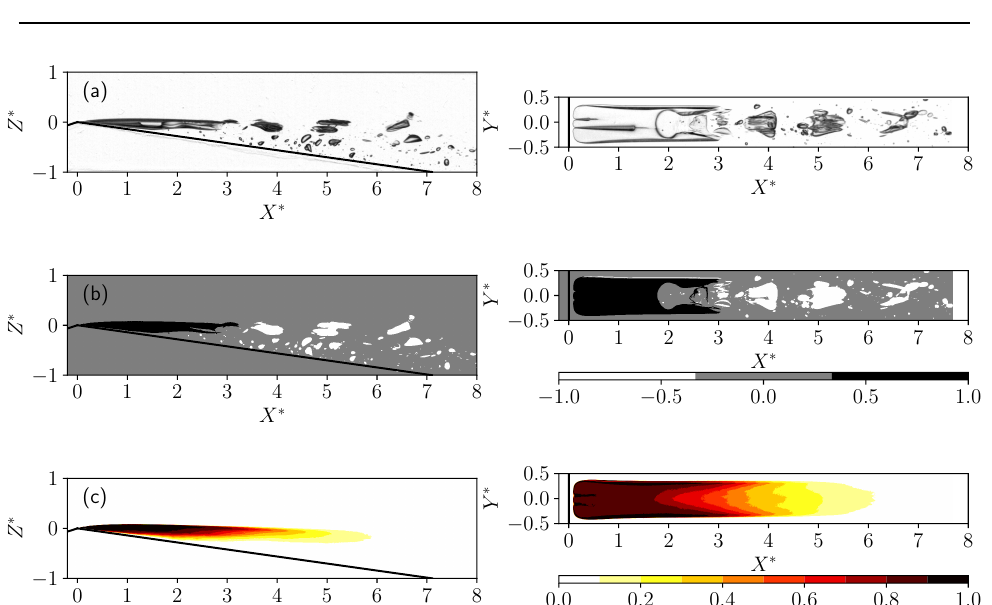
Figure 2. ( a ) Typical side (left column) and top (right column) instantaneous views. The flow is from left to right. Re 1300, σ 1 = 5.10 0.04 and σ 2 = 0.70 0.03. ( b ) Illustration of the image processing. (cid:39) ± ± The treatment is based on binarization, morphological closing and regions labeling (see text for details). The large region close to the throat is displayed in black in the figure, whereas the other small gaseous cavities are in white and the background in pale gray. A binary image (not shown) is generated that only contain the large region close to the throat. ( c ) Time average of 3000 binary images showing the average attached cavity on the side and top views. The colorbar corresponds to the proportion of time when the cavity is